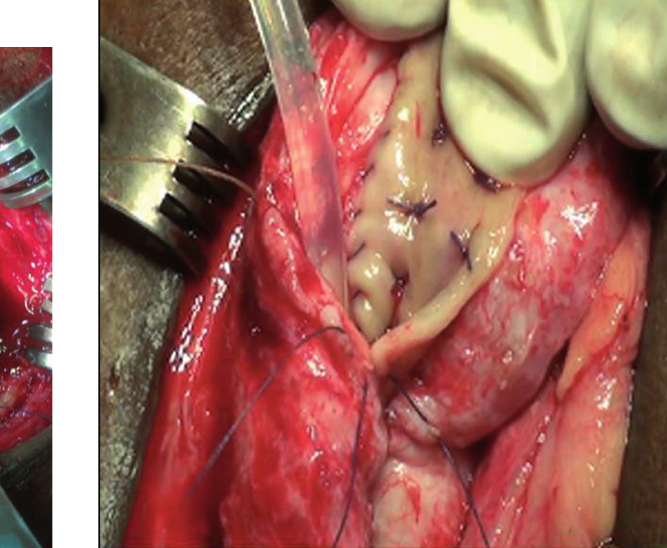
Figure 2 - Dorsolateral